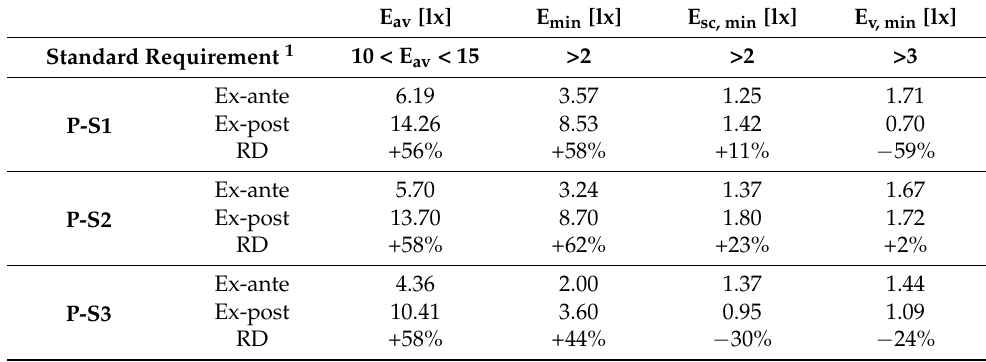
Table 6. Lighting performances of the ex-ante and ex-post installations for the pedestrian sections.